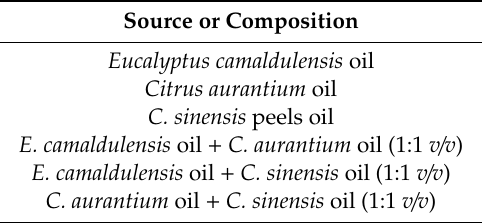
Table 1. The essential oils and their mixtures used in this